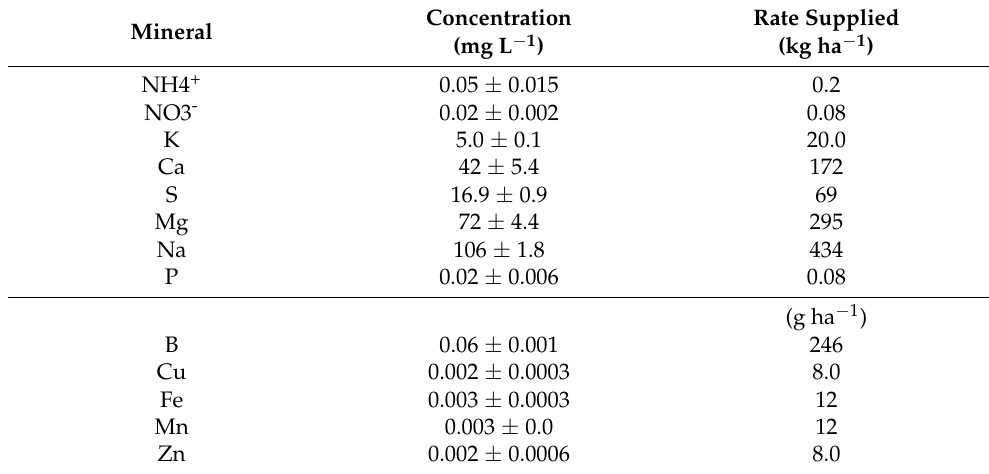
Table 2. Nutrient concentration (mg L − 1 ) in irrigation water and the calculated nutrient supplied (kg ha − 1 year − 1 ) by irrigation with approx. 4.1 ML ha − 1 under field conditions. Concentration Mineral (mg L − 1